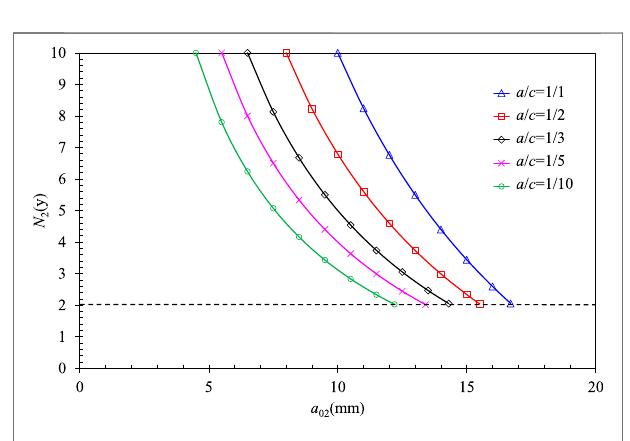
FIGURE 4 | Residual service lifes of different crack aspect ratios for embedded cracks in RPV cylinders.